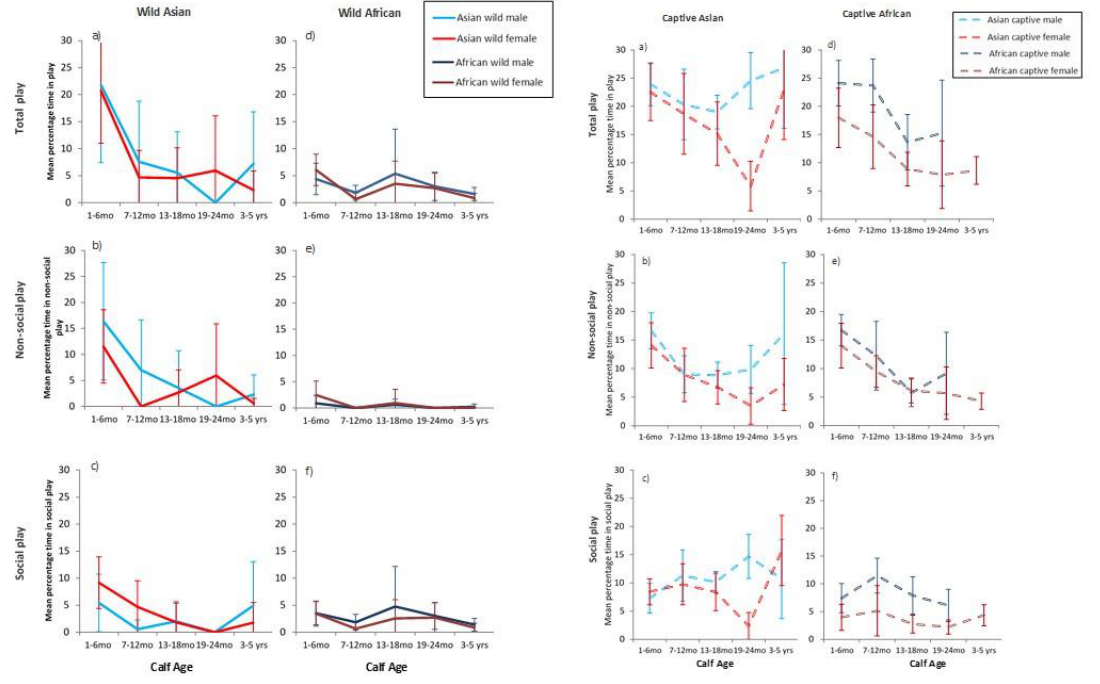
Figure 1. Mean percentage of observation time in play ( ± 95%CI) for wild and captive calves across ages and by sex.